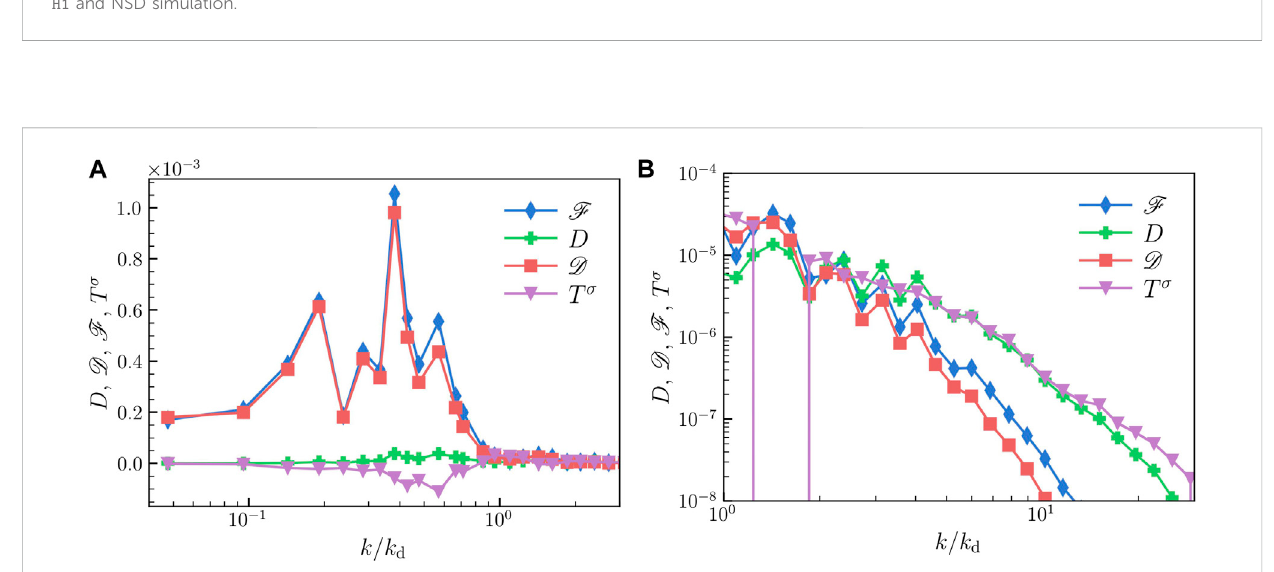
FIGURE 8 Different contributions towards the energy budget for (A) k < k d and (B) k > k d obtained from NSD